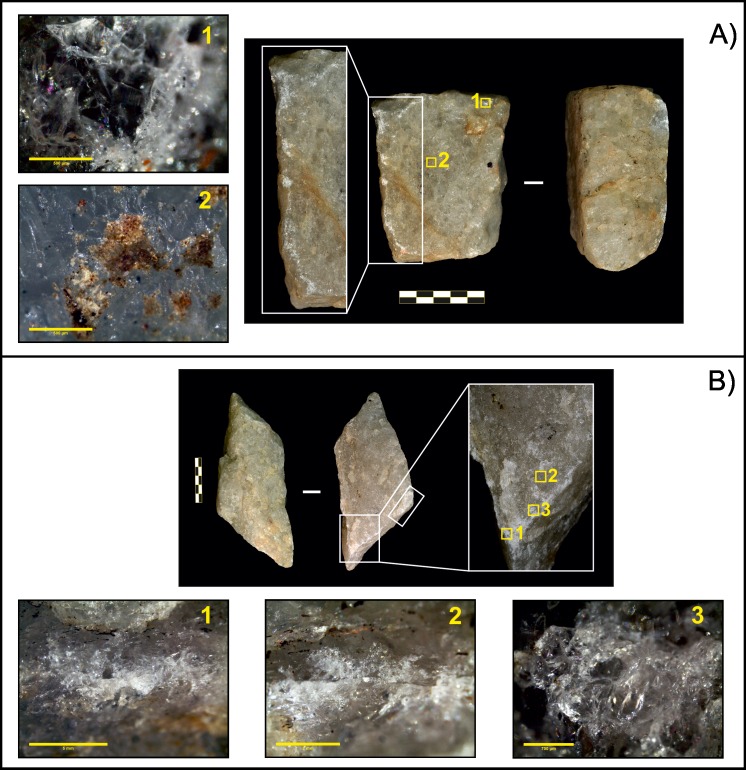
Quartzite active elements.A) Piece O35. 1. Detail of crushing associated with detachment of small crystal fragments (80×, scale 500 μm). 2. Residues (80×, scale 500 μm). B) Piece O11. 1 and 2. Crushing with associated microfractures (10× and 20×, scales 5 mm and 2 mm). 2. Impact point (50×, scale 700 μm).